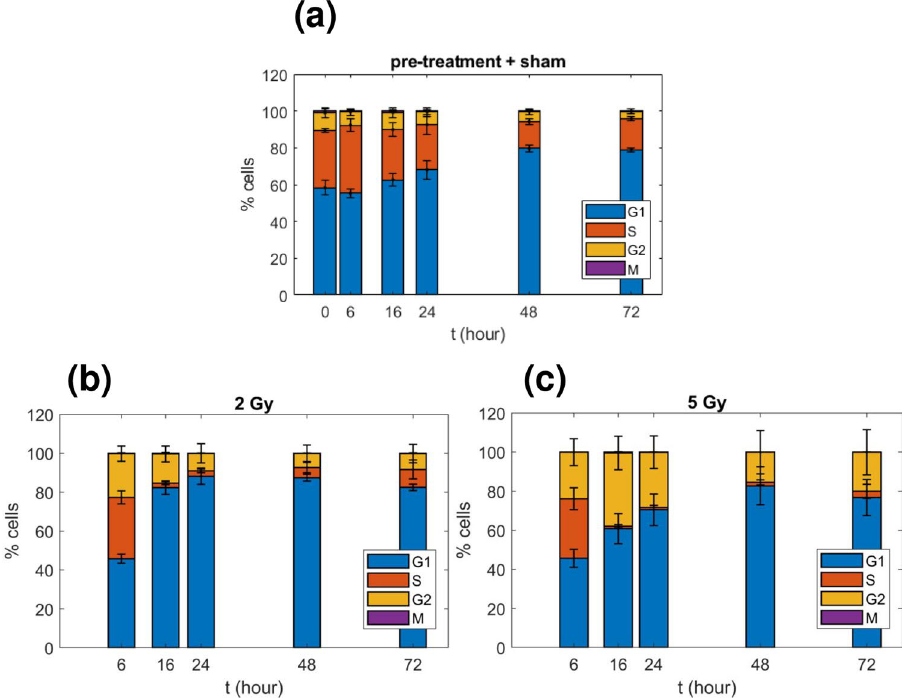
Figure 3. Experimental cell-cycle distribution in sham and for irradiated samples. Percentages of cells in the four cell-cycle phases as a function of time respectively for: (a) the pre-treatment and the sham conditions, (b) the 2 Gy irradiated condition, and (c) the 5 Gy irradiated condition (data from Table 1). Percentages of cells in the M-phase are generally too low to be appreciated in the plot. Errors are reported as standard deviations at 1 σ .